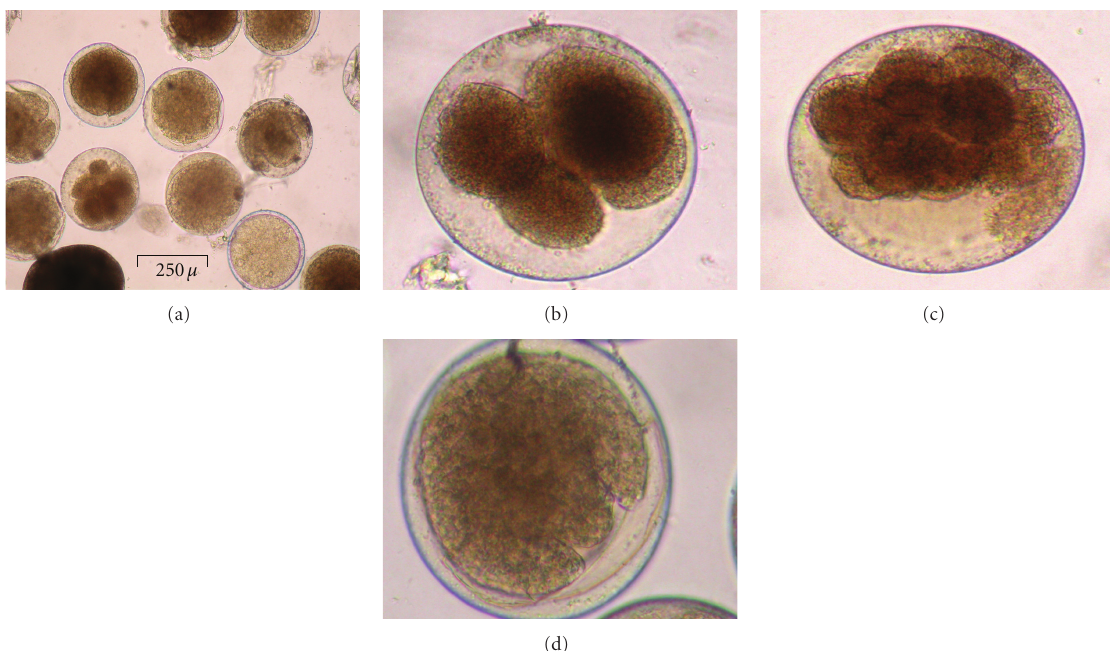
Figure 8: Eggs of Euphausia sibogae collected from station 6. (a) Eggs of E. sibogae , (b, c) enlarged view of eggs with various stages of cell division, and (d) enlarged view of nauplii development inside the